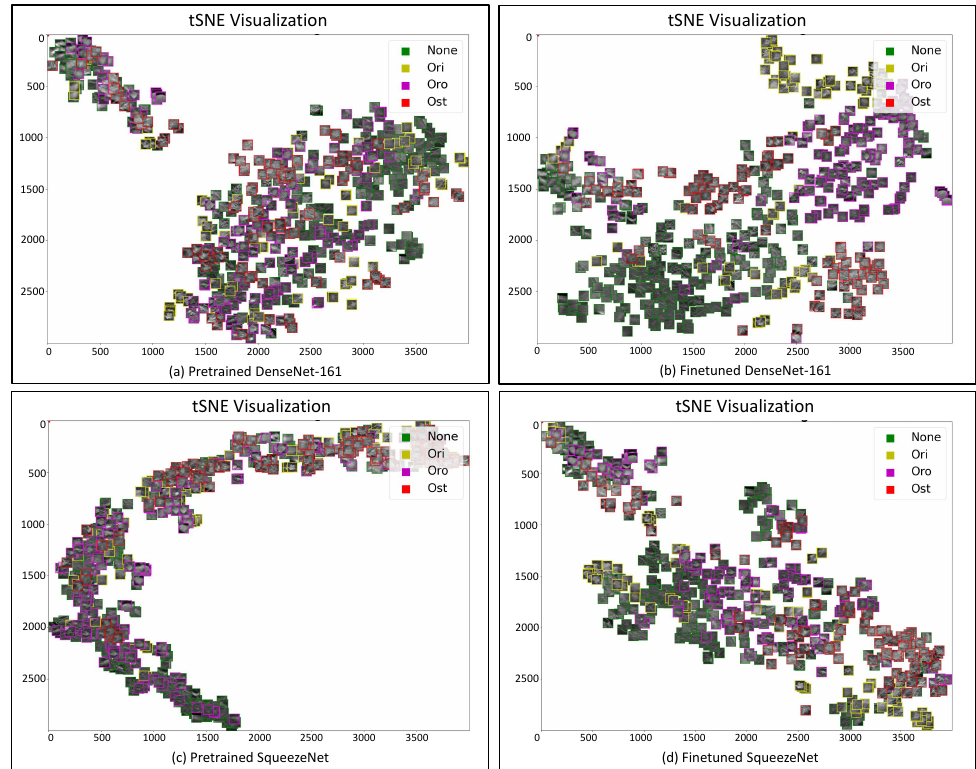
Figure 9. The t-SNE embedding plots of the features extracted from pretrained ( a , c ) and fine-tuned ( b , d ) DenseNet-161 and SqueezeNet, respectively, on the validation set of 1st fold. It is clearly visible that the fully TL paradigm does not allow a clear clustering of the features in low-dimensionality space, whereas the finetuned model is able to discover more discriminative features with respect to its pretrained-only